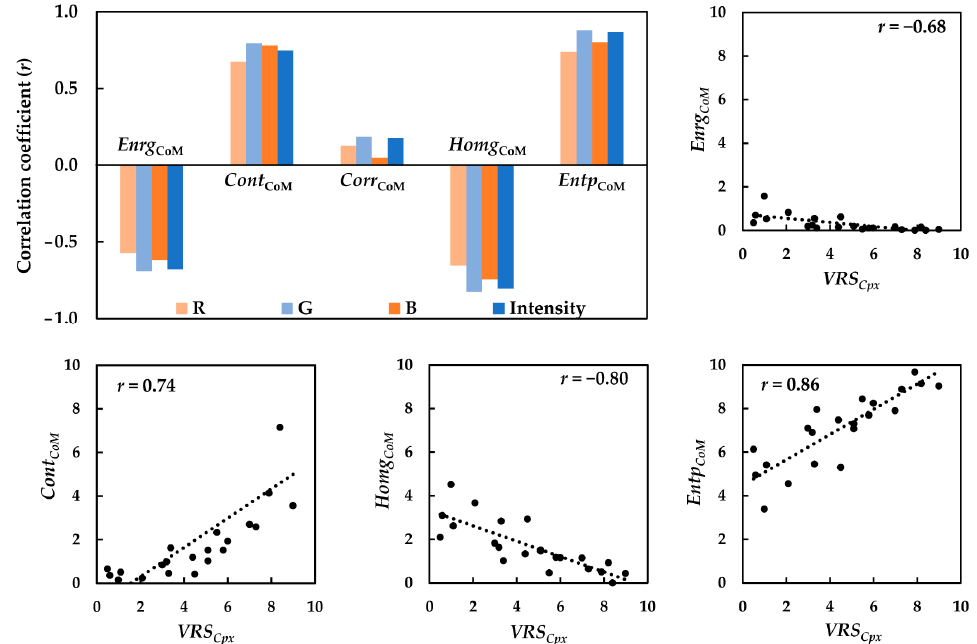
Figure 13. The correlation between the VRS Cpx of the textiles and the CoM features of the textile images computed with the CoM distance d = 100 pixels for the R, G, and B channels and the sRGB intensity images ( top left ). Scatter plots of Enrg CoM , Cont CoM , Homg CoM , and Entp CoM versus the corresponding VRS Cpx for the sRGB intensity images.